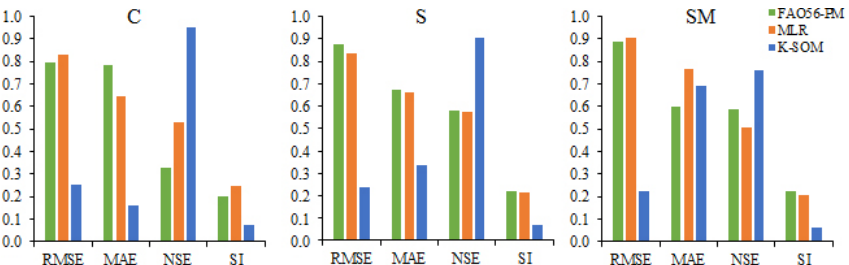
Figure 8. Error statistics (root mean square error – RMSE, mean absolute error – MAE, scatter index – SI and Nash–Sutcliffe efficiency – NSE) for the multiple stepwise regression (MLR), FAO-56 Penman–Monteith reference crop evapotranspiration (FAO56–PM), and